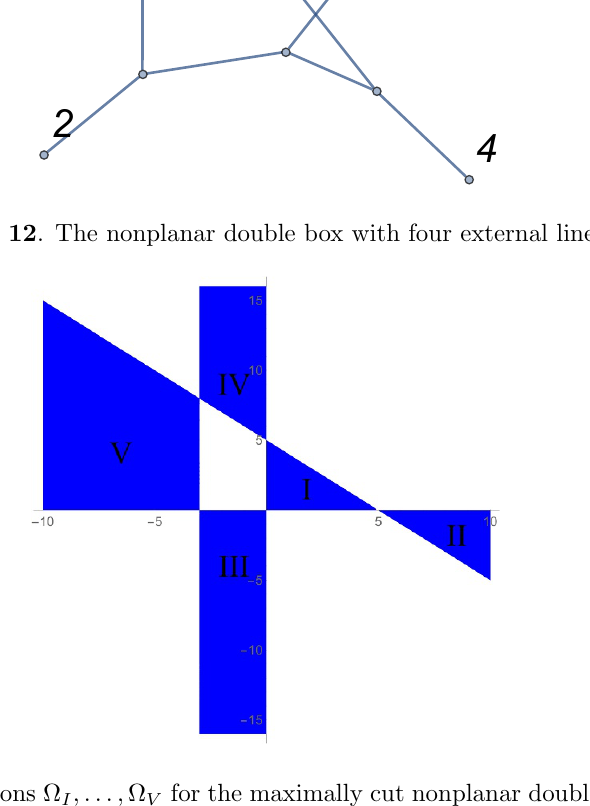
0, where F is the Baikov (cid:21)